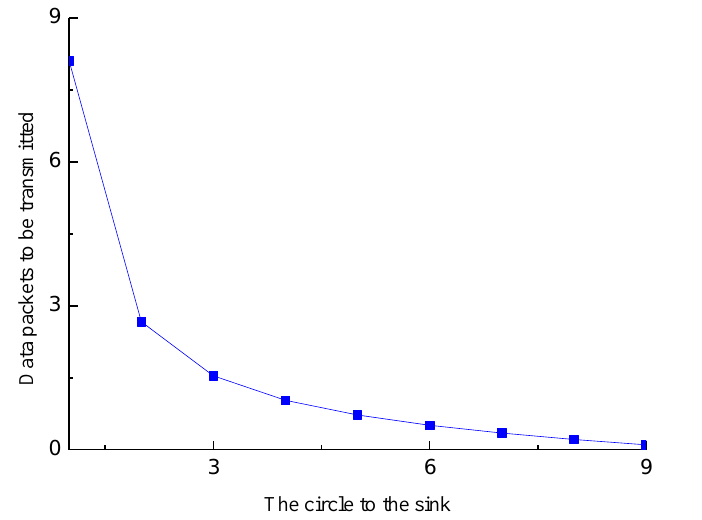
Figure 4. The average number of data packets transsmitted by each sensor node.